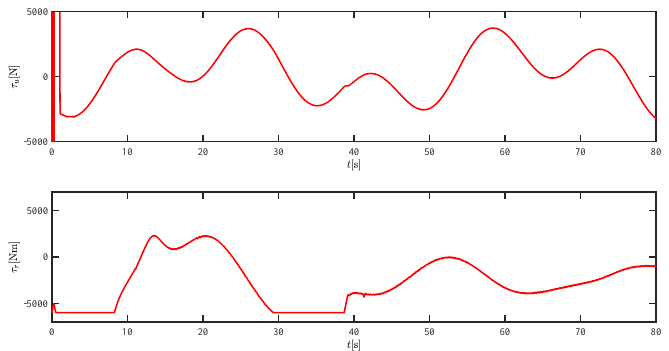
Figure 33. The force τ u and moment τ r under severe